Question: In one sentence, what is this figure communicating?
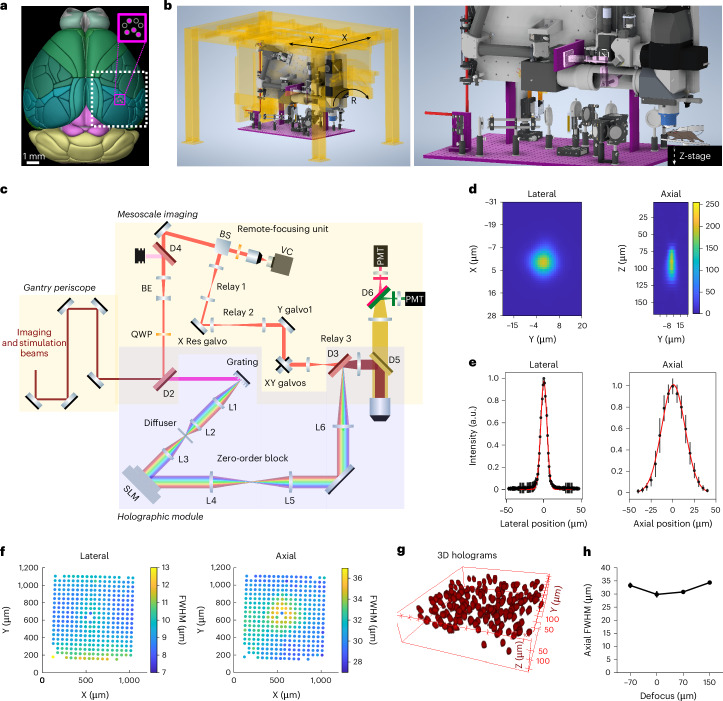
Answer: A 2p-RAM with temporally focused 2p holographic photostimulation. a , Schematic dorsal view of the mouse brain with putative functional areas demarcated (image credit, Allen Institute for Brain Science, Allen Brain Explorer 2 (ref. 53 )). The holographic mesoscope allows targeted photostimulation in a 1 × 1 mm FOV (magenta square) combined with simultaneous mesoscale imaging across a nominal 5 × 5 mm imaging FOV (dotted white square). b , Left, CAD model of the holographic mesoscope platform. Right, blow-up of the holographic module attached to the main frame of the mesoscope. The 3D-SHOT holographic module consists primarily of the highlighted magenta parts and the optics on the highlighted extension breadboard. c , Simplified schematic of the optical path. QWP: quarter-wave plate, BE: beam expander, L n : achromatic doublet, D n : dichroic mirror; BS: polarization beamsplitter; VC: voice coil. d , Example lateral and axial 2p fluorescence intensity profiles of a single, temporally focused holographic illumination spot. e , Optical lateral and axial point-spread functions. Error bars, s.e.m. Red curve, Gaussian fit; lateral full-width-half-maximum (FWHM), 9 µm; axial FWHM, 32 µm; n = 551 holograms. a.u., arbitrary units. f , 2D grid of single-spot holograms ( n = 538) showing the extent of the holographic FOV and the distribution of lateral and axial resolution across the FOV. g , Example point-cloud 3D holograms. h , Axial point-spread function as a function of digital Z -defocus. n = 38, 38, 38 and 37 holograms for −70 µm, 0 µm, 70 µm and 150 µm defocus, respectively. Error bars, s.d. Source data